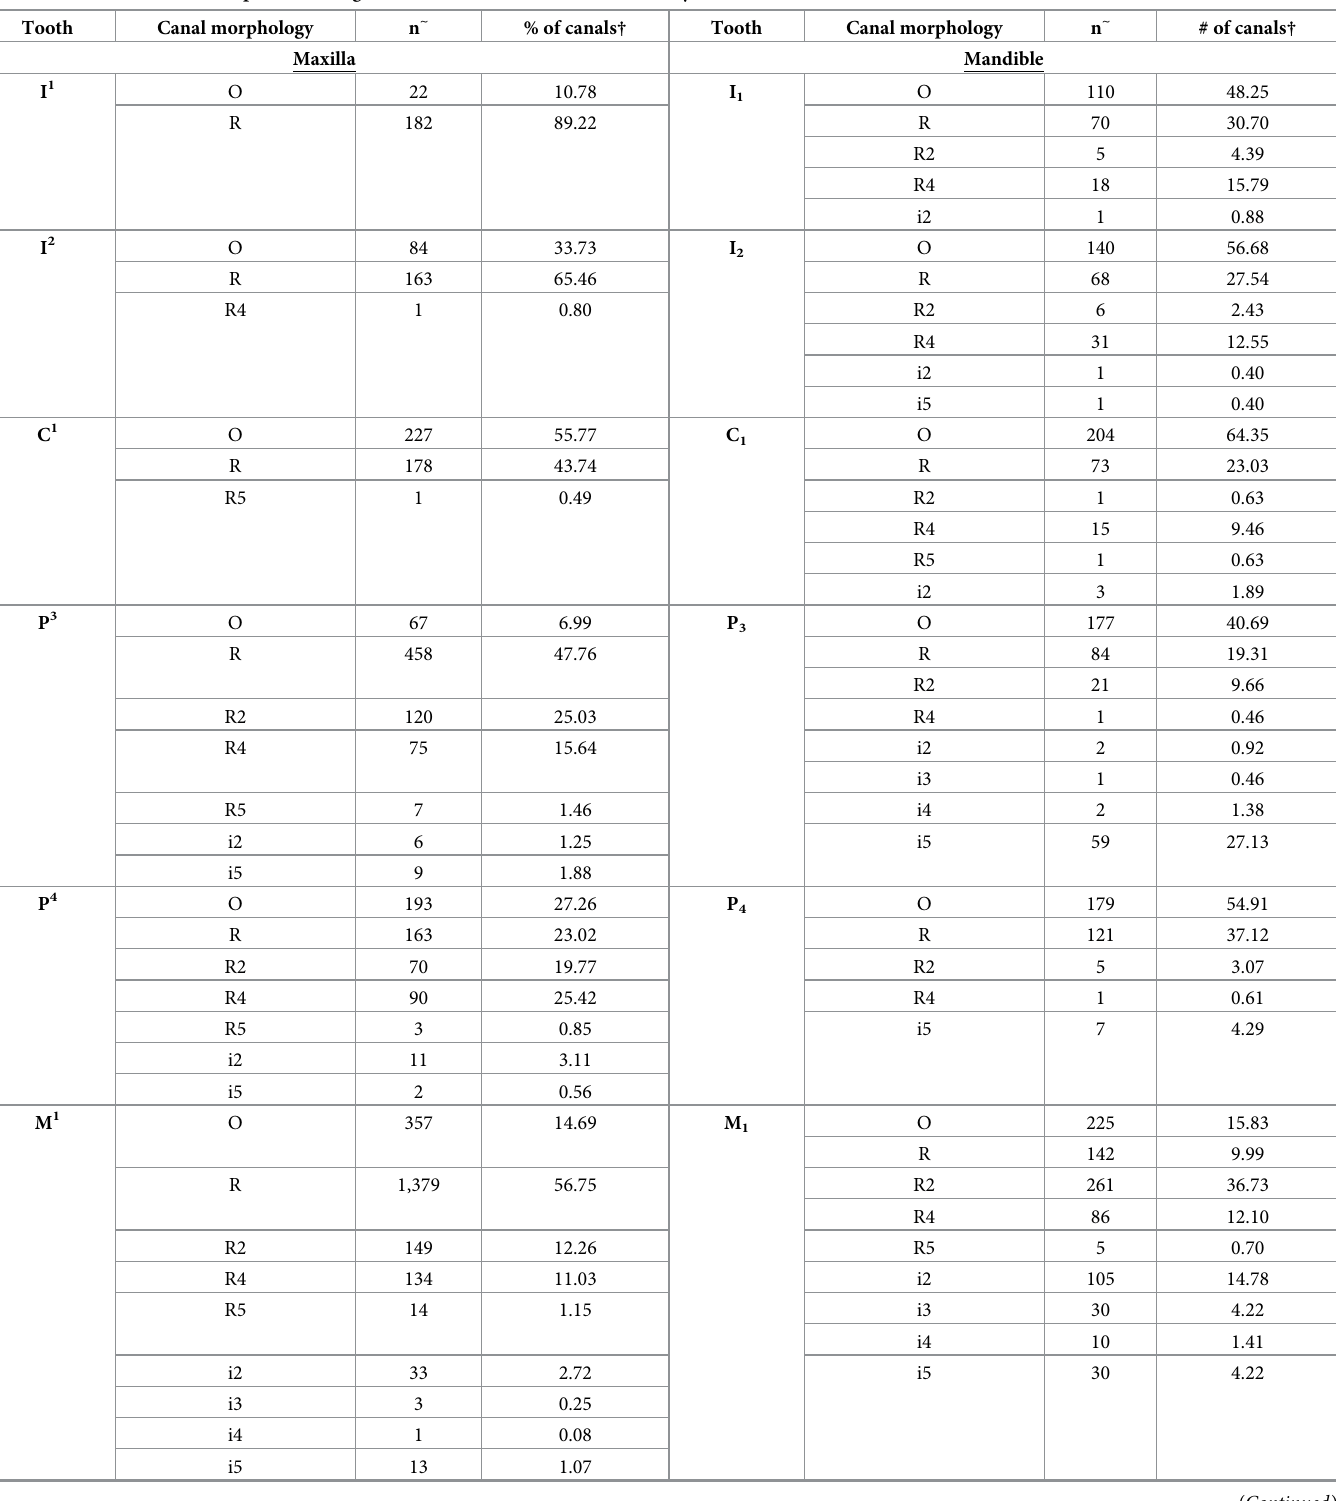
Table 10. Number of canal shapes and configurations in the maxilla and mandible by tooth.